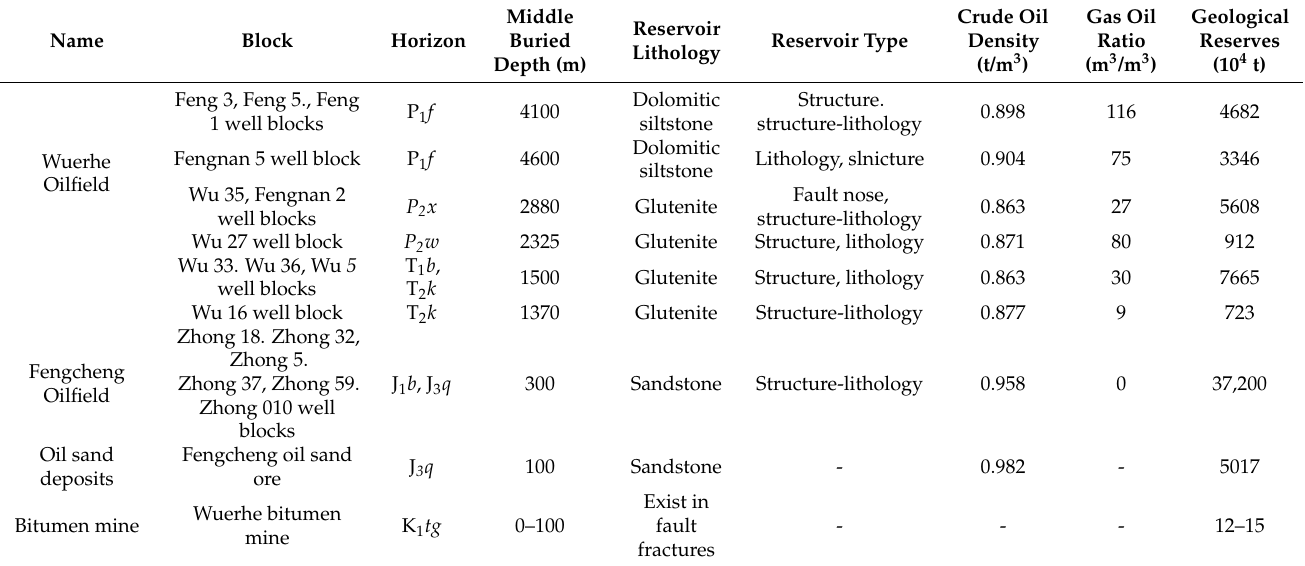
Table 1. Basic date for the discovered reservoirs in the Wuerhe